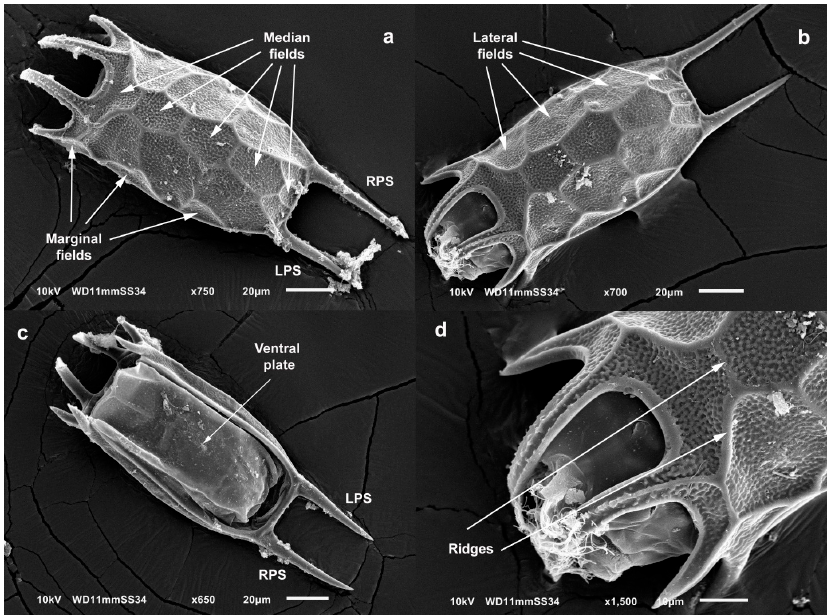
Figure 10. Morphology of Keratella huapanguensis sp. nov. ( a ). Dorsal view: arrows indicate the median and the marginal fields, RPS (Right Posterior Spine), LPS (Left Posterior Spine). ( b ). Dorsal view: arrows indicate lateral fields. ( c ). Ventral view, RPS (Right Posterior Spine), LPS (Left Posterior Spine). ( d ). Anterior margin of the lorica in dorsal view, arrows indicate a ridge. Females from Huapango dam. Type locality and types: Huapango dam is located in the state of Mexico, Mexico (19.9483 N, -99.7144 W). Sample collected on 17 August 2014. It is a freshwater system, located at 2619 masl. The surface of the dam is 1000 ha, with a maximum depth of 14 m. It belongs to the basin of the Lerma River that runs 708 km from the state of Mexico to Jalisco, flowing out into Chapala Lake. Holotype: A parthenogenetic female mounted on a permanent slide. Paratypes: 10 females in a tube with ethanol. Holotype and paratypes are deposited in the Zooplankton Reference Collection of El Colegio de la Frontera Sur with accession numbers ECO-CH-Z- 10591 and ECO-CH-Z-10592, respectively. Differential diagnosis: Keratella huapanguensis sp. nov. Most closely resembles the Keratella tropica species, K. cuitzeiensis sp. nov., and K. albertae sp. nov. It is diagnosed by a lorica almost rectangular in dorsal view. Anteromedian, mesomedian and posteromedian fields are hexagonal with almost the same size (Figure 10a,b). The posteromedian remnant is rounded and small (Figure 10a). It presents two short posterior spines (Figure 10a,c). The dorsal plate is ornamented by a reticular-granular pattern (Figure 10d). Description: Lorica stiff, the anterior margin of the lorica is slightly wider than the posterior margin. The posterior end of the lorica is almost straight, with two stiff and rel- atively short posterior spines, the right one slightly longer than the left one (Figure 10a,b). With three pairs of anterior spines, which are elongated (Figure 10d). Anteromedian spines are the longest and recurved. Frontomedian field is an open short hexagon with ridges prolonged into anteromedian spines (Figure 10a,d). The ventral plate is delicate,